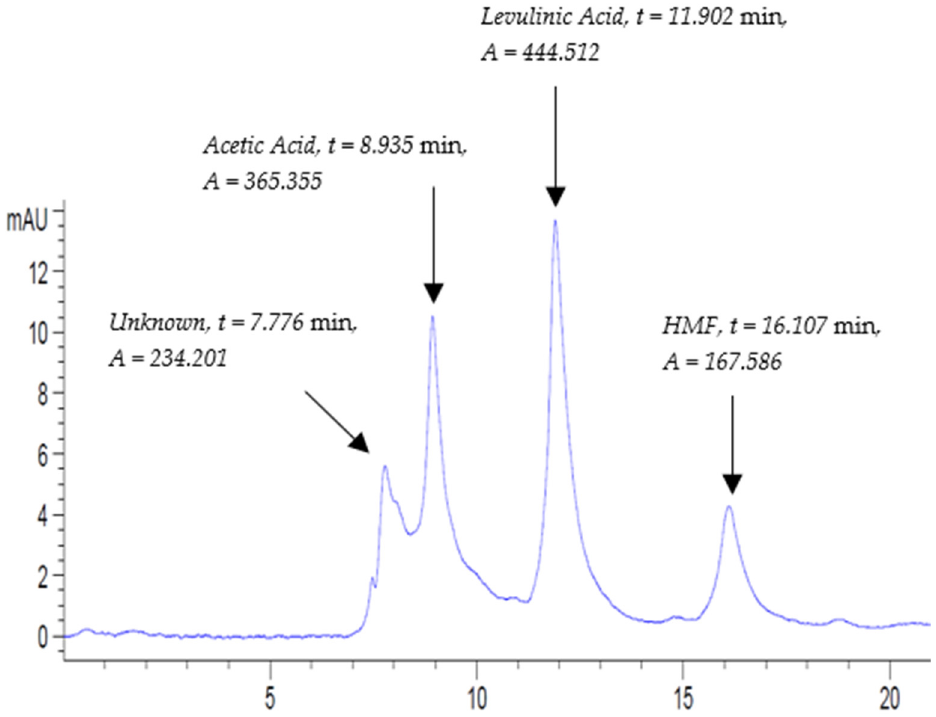
Figure 4. Balsamic vinegar B.VIN(A) chromatogram at UV-210 nm at the following conditions: flow rate, 0.3 mL/min; column temperature, 30 °C; and run time, 20 min.